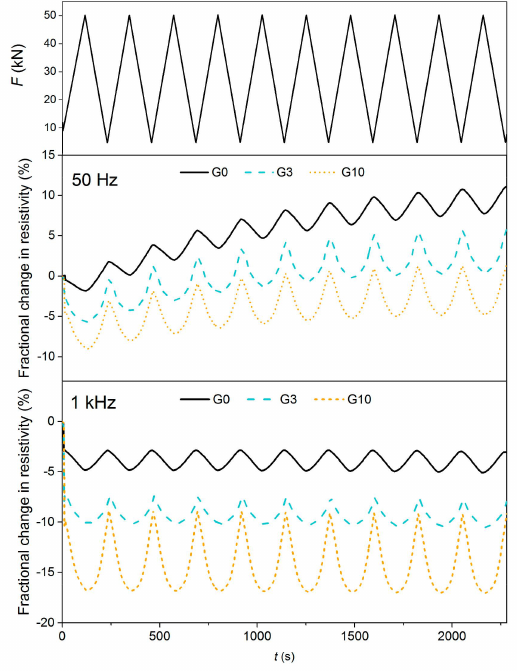
Figure 12. Compression sensitivity of composites G0, G3 and G10 under AC measurement at two di ff erent frequencies (50 Hz and 1